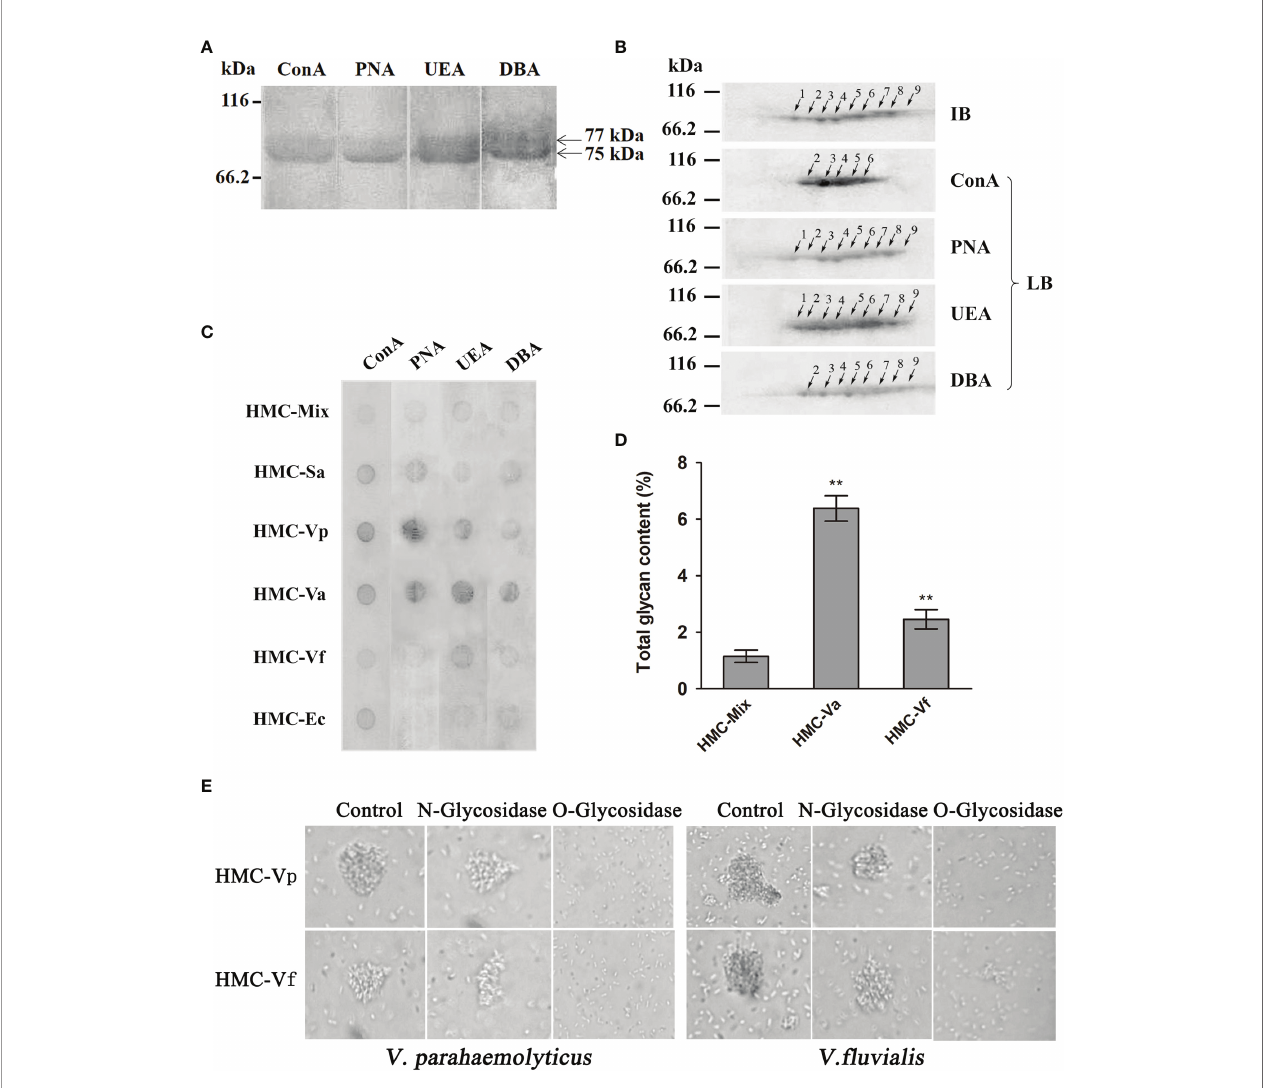
FIGURE 5 | Analysis of glycosylation of hemocyanin from L. vannamei . (A) Lectin-blotting analysis of hemocyanin with ConA (1:1,000), PNA (1:100), UEA (1:500), and DBA (1:1000), respectively. (B) 2-D immunoblotting and 2-D lectin blotting with ConA, PNA, UEA, and DBA analysis of hemocyanin. IB, immunoblotting; LB, lectin blotting. Western blotting was performed using rabbit anti-shrimp HMC antisera (1:1,000 dilution) and goat anti-rabbit IgG-HRP (1:3,000 dilution) antibodies. Lectin-blotting analysis were carried out as the same descriptions with (A) . (C) Comparative analysis of the sugar content among six bacteria-binding hemocyanin by dot lectin blotting. ConA (1:20), PNA (1:5), UEA (1:5), DBA (1:5), and 50 m g/ml of HMC-Mix, HMC-Sa, HMC-Vp, HMC-Va, HMC-Vf, and HMC-Ec were used. (D) Comparison of sugar content of 200 m l of 250 m g/ml HMC-Mix, HMC-Va, and HMC-Vf by the method of phenol-sulfate acid. (E) Comparison of agglutinative